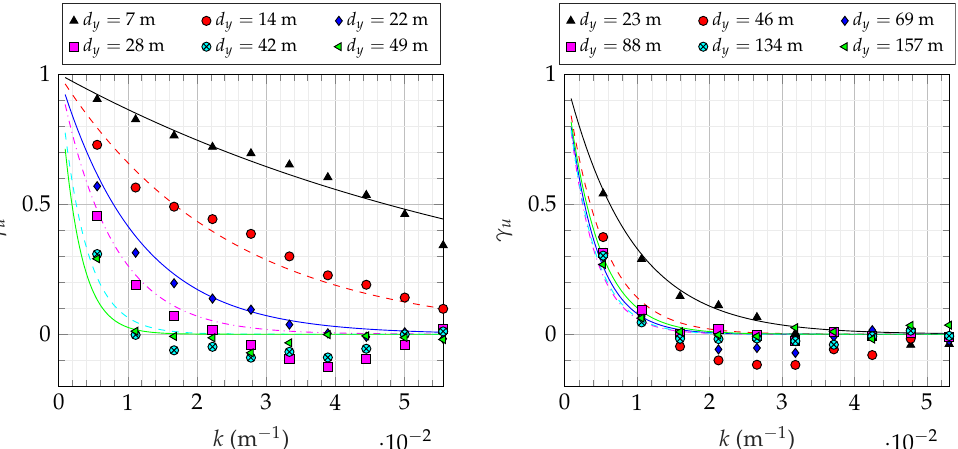
Figure 15. Same as Figure 13, except that the solid and dashed lines correspond to the coherence model derived from Bowen et al.